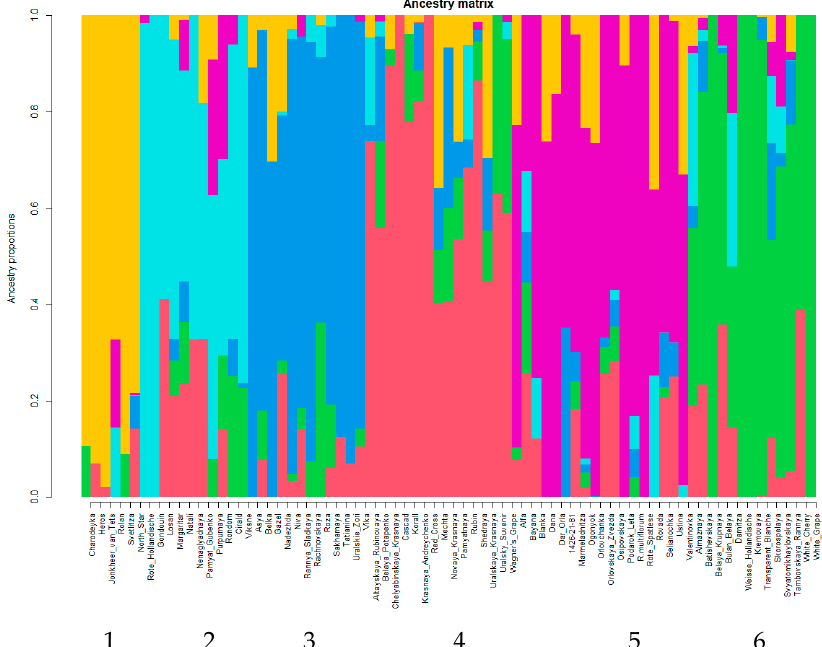
Figure 4. Population structure for 75 red currant genotypes. Colors represent different assigned clusters. The x -axis provides accession names and respective assigned cluster whereas the y -axis provides the probability of each accession belonging to the assigned cluster. Numbers in the bottom of figure correspond to cluster’s numbers presented in the text.